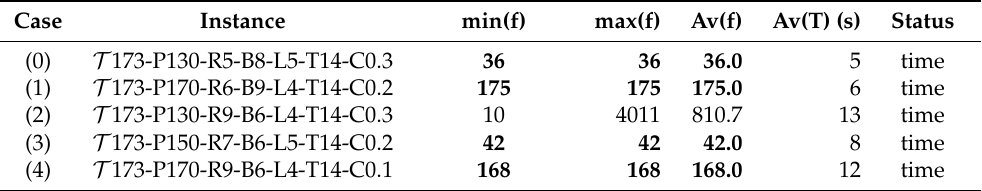
Table 8. Heuristic results for unsolved problem